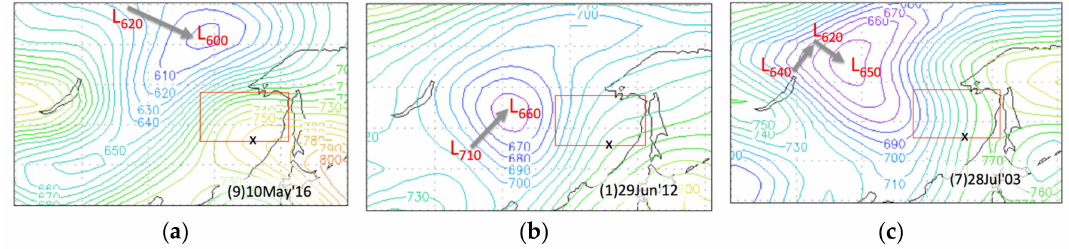
Figure 8. Low-pressure systems associated with July-Fire. ( a ) (9)10May (cid:48) 16; ( b ) (1)29Jun (cid:48) 12; ( c ) (7)28Jul (cid:48)